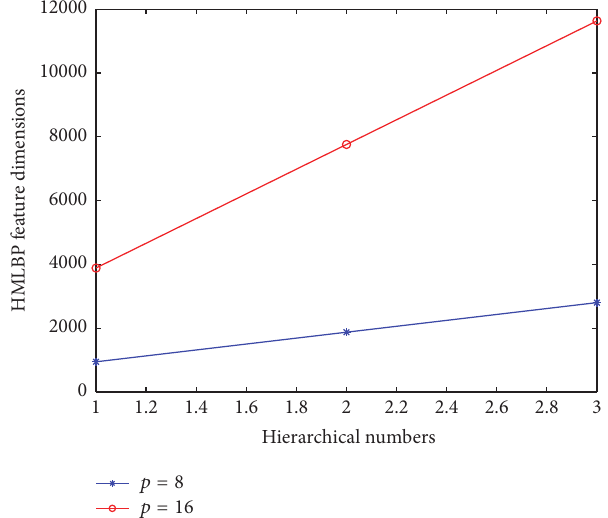
Figure 1: The dimension of HMLBP under the subsize of 32 ∗